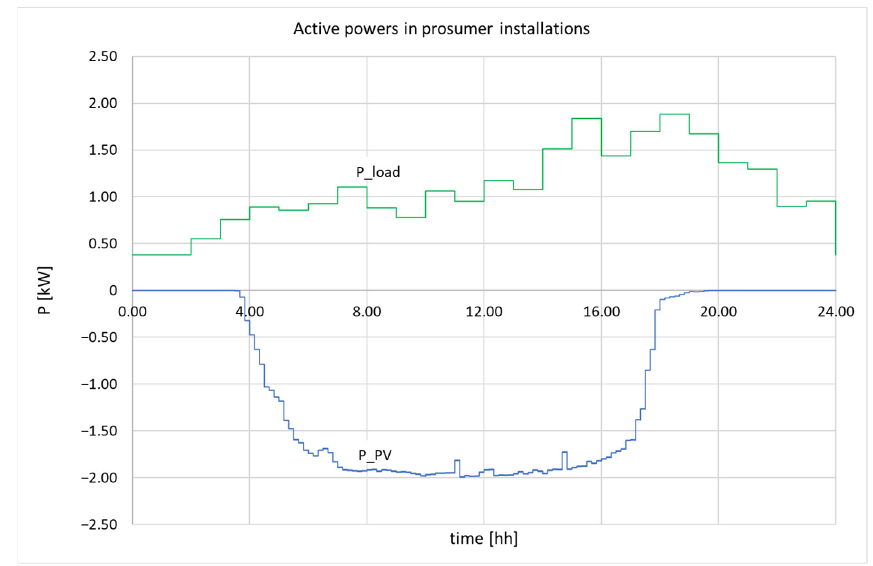
Figure 5. Load and PV profiles used in the